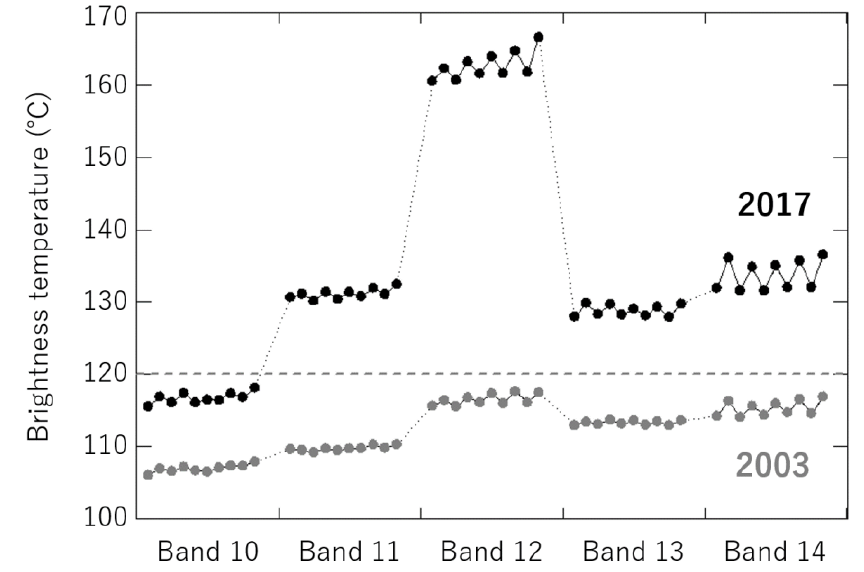
Figure 7. Expected saturation brightness temperature for each detector of each TIR band in 2003 (gray dots) and in 2017 (black dots). The higher saturated brightness temperatures in 2017 are due to the TIR sensor’s sensitivity degradation that caused a wider dynamic range in the sensor. Note that the surface temperature of the Moon can exceed 120 °C (dashed line).